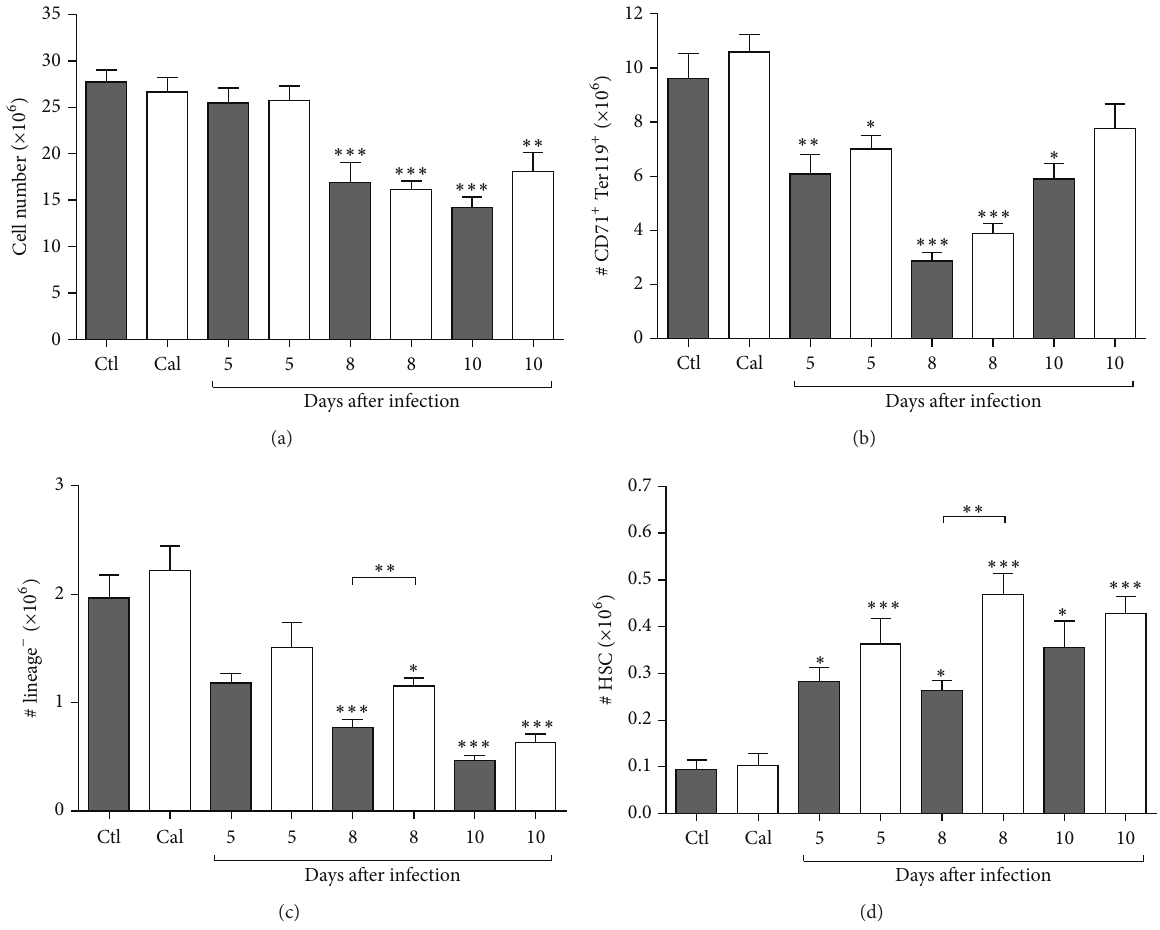
Figure 4: Impact of calcitonin on bone marrow hematopoiesis during Plasmodium infection. Mice were treated with calcitonin (white bars; Cal) or with PBS (grey bars; Ctl) during 5 consecutive days and were infected with P. c. adami DK parasites (10 5 pRBCs) on the 3rd day of treatment. Data from uninfected controls (Ctl, Cal 𝑛 = 3 ) is included for comparison. Mice were sacrificed 5 ( 𝑛 = 8 ), 8 ( 𝑛 = 8 –12), or 10 ( 𝑛 = 3 -4) days after infection, and femoral and tibia bone marrow was aseptically recovered for analysis of numbers of total cells (a), erythroid cells (b), lineage − cells (c), and hematopoietic stem cells (d) by cytofluorometry. Data are mean ± SEM from 3 independent experiments (a total of 19–24 mice per infected group); values are compared to respective uninfected control mice and between the two infected groups using a one-way ANOVA test. ∗ 𝑃 < 0.05 ; ∗∗ 𝑃 < 0.01 ; ∗∗∗ 𝑃 < 0.001